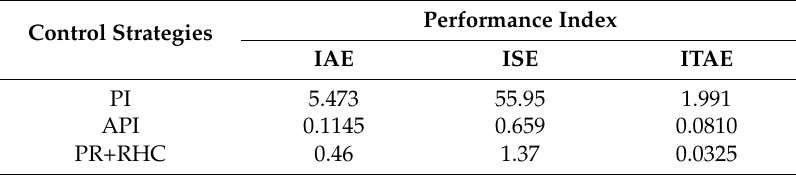
Table 3. Performance evaluation of designed control strategies for I d . Performance Index Control Strategies